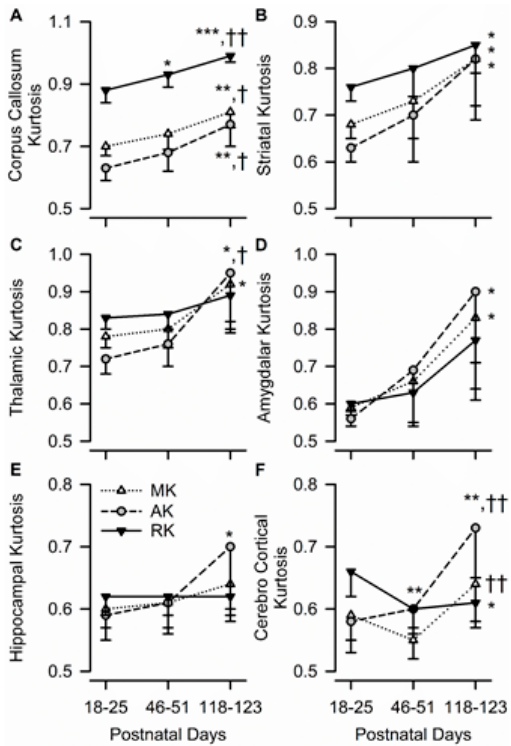
Figure 5. Age dependence of axial, radial, and mean kurtosis (AK, RK, and MK, respectively) in different ROIs of the male guinea pig brain. Graphs illustrate the age dependence of AK, RK, and MK in the corpus callosum ( A ), striatum ( B ), thalamus ( C ), amygdala ( D ), hippocampus ( E ), and cerebral cortex ( F ) in the brain of male guinea pigs. Symbols and error bars represent mean and SD of results obtained from six guinea pigs examined longitudinally at PND 18-25, PND 46-51, and PND 118-123. Whenever ANOVA revealed a significant effect of age on a given parameter, the Tukey post-hoc test was used for multi-group comparisons. Asterisks and daggers are used for comparison, with data obtained at PND 18-25 and PND 46-51, respectively. *, p < 0.05; **, p < 0.01; ***, p < 0.001; †, p < 0.05; ††, p < 0.01.